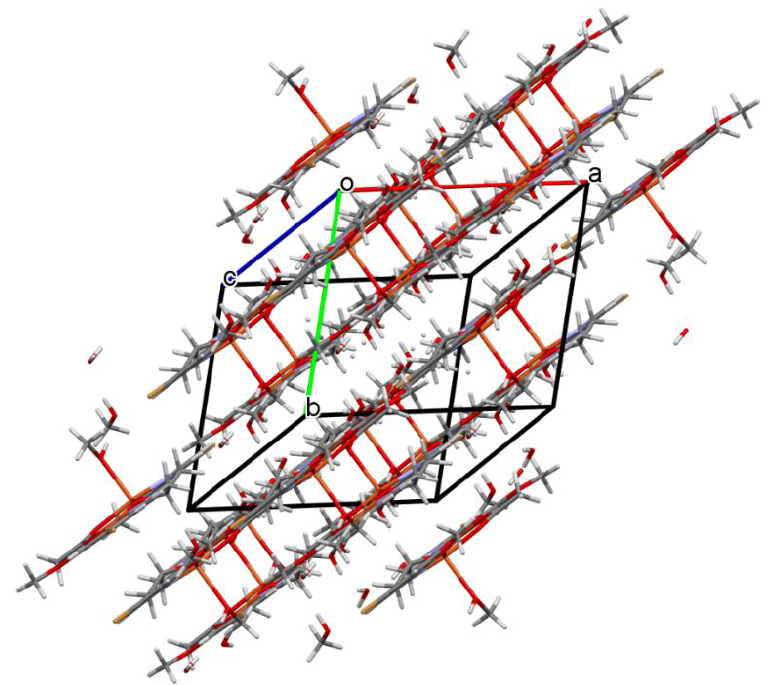
Figure 6. Packing of complex 2 (the hydrogen bonds were omitted for the sake of clarity).